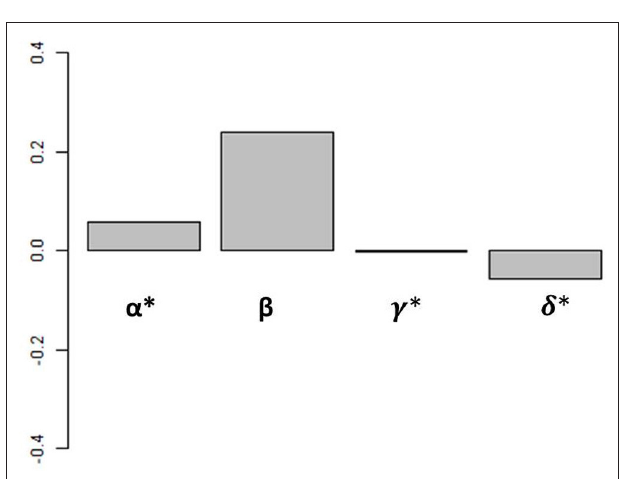
FIGURE 4 | Weighted contribution of each driver to iron assimilation efficiency variance. Values are calculated over the global ocean. Values of α , γ , and δ have been multiplied by 100 for